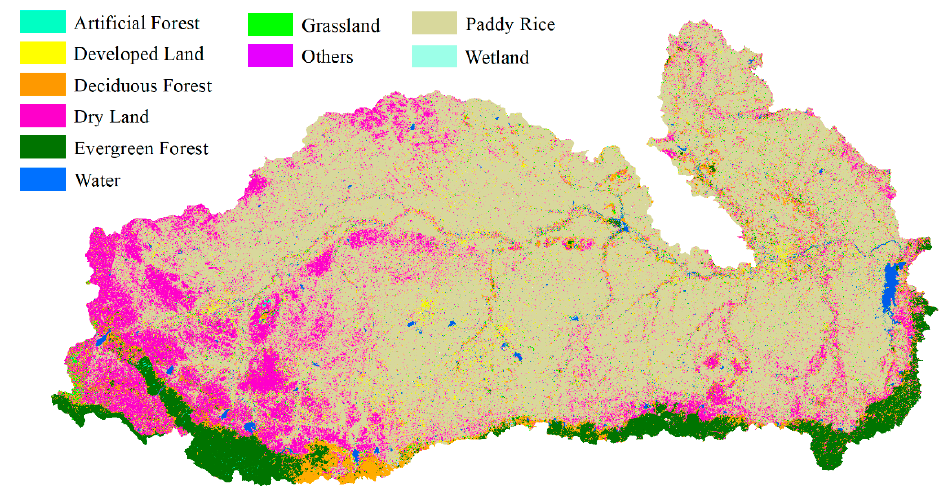
Figure 6. Land cover map of the aggregated pre-trained neighborhood spatial relationship and fuzzy classification membership.